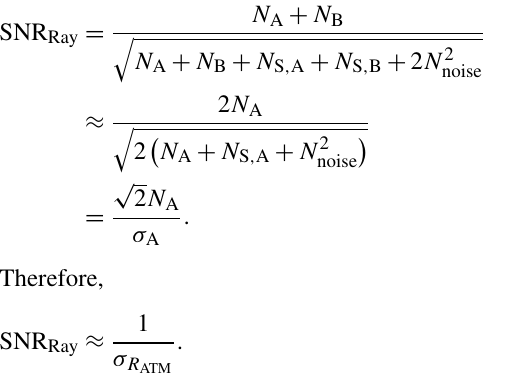
Figure A1. The verification process of Eq.